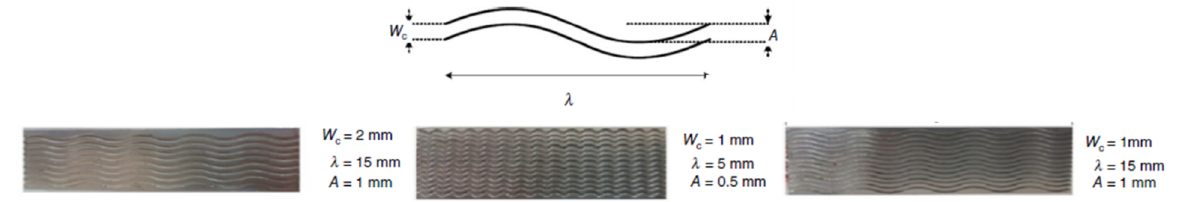
Figure 7. Wavy microchannel model [94].